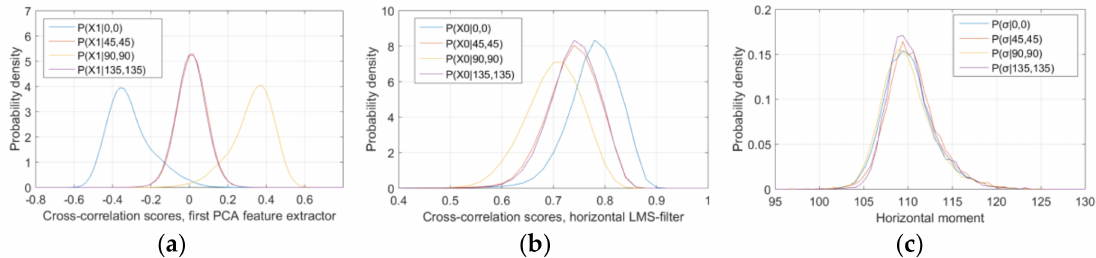
Figure 5. ( a ) Probability densities for the extracted feature using the first PCA extractor (second PCA component in Figure 4c), calculated on training data in Cx channel with four different orientations; ( b ) Probability densities for extracted feature using horizontal LMS-filter; ( c ) Probability densities for horizontal